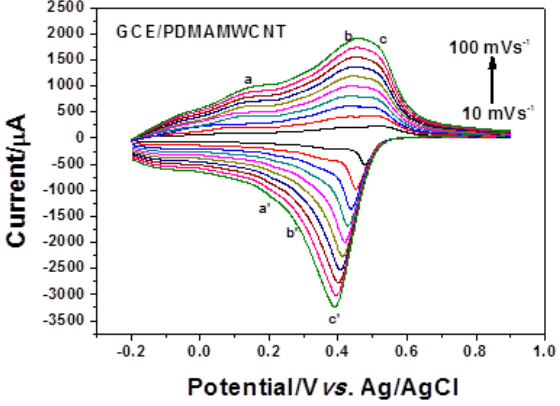
Figure 4. Cyclic voltammograms of the GCE/PDMA-MWCNT composite in 1 M HCl at scan rates of 10 to 100 mV·s − 1 from the inner to the outer CVs measured in 10 mV·s − 1 intervals.